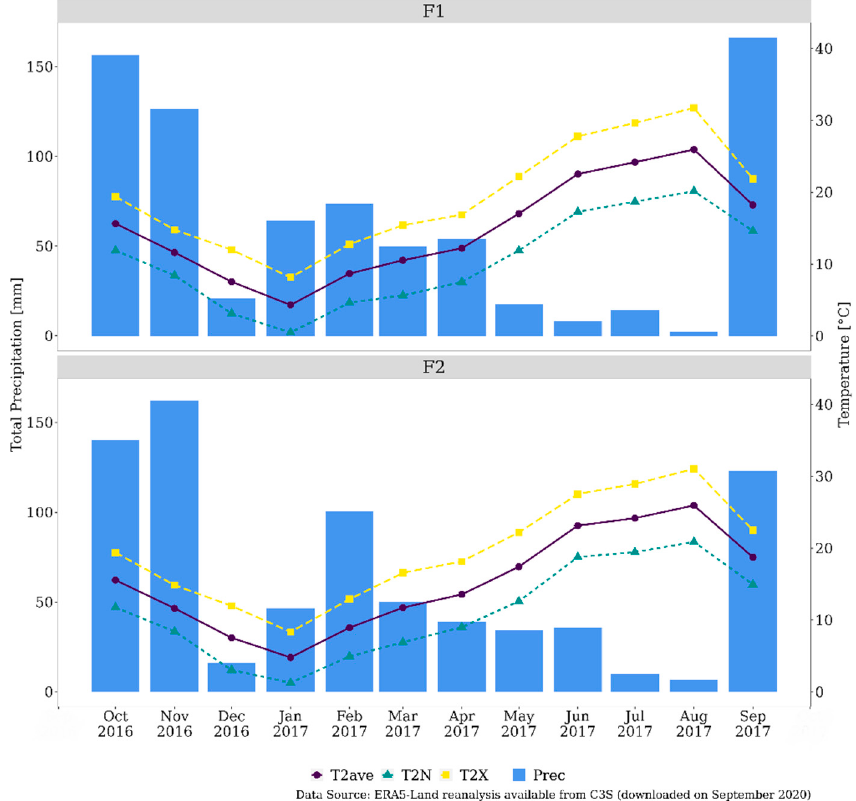
Figure 5. Weather conditions in the hop farms under investigation: monthly data of maximum (T2X), minimum (T2N), average (T2ave) temperature, and total precipitation (TP). Farm code: F1: Latium; F2: Tuscany. Table 4. Weather conditions in the hop farms under investigations. (a) Monthly data of temperature and precipitation; (b) Monthly anomalies of the same variables (reference period 1981–2010), referred to the correspondent administrative re- gions. (a) Farm Code